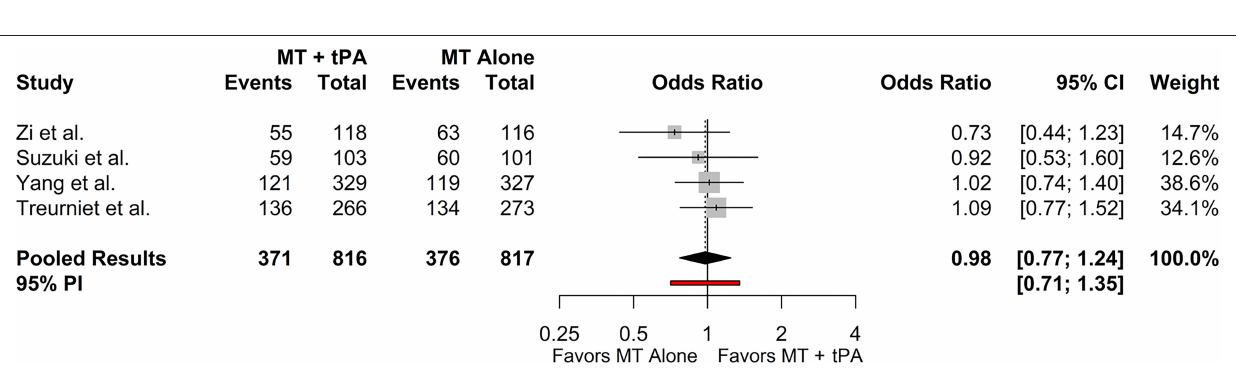
FIGURE 3 | Forest plot of comparisons of mRS 0–2 at 90 days. Pooled results were computed via the Mantel-Haenszel method, using restricted effects maximum likelihood for estimation of the between-study variance component and Hartung-Knapp adjustment to calculate a 95% confidence interval (CI) around the pooled effect size. A 95% prediction interval (PI) for the pooled results are also displayed as a red bar.